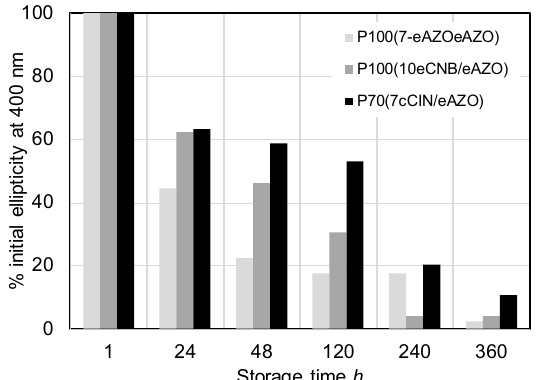
Figure 9. Stability of the photoinduced chirality of P 100 (7eAZO / eAZO) , P 100 (10cCNB / eAZO) and P 70 (7cCIN / eAZO) .